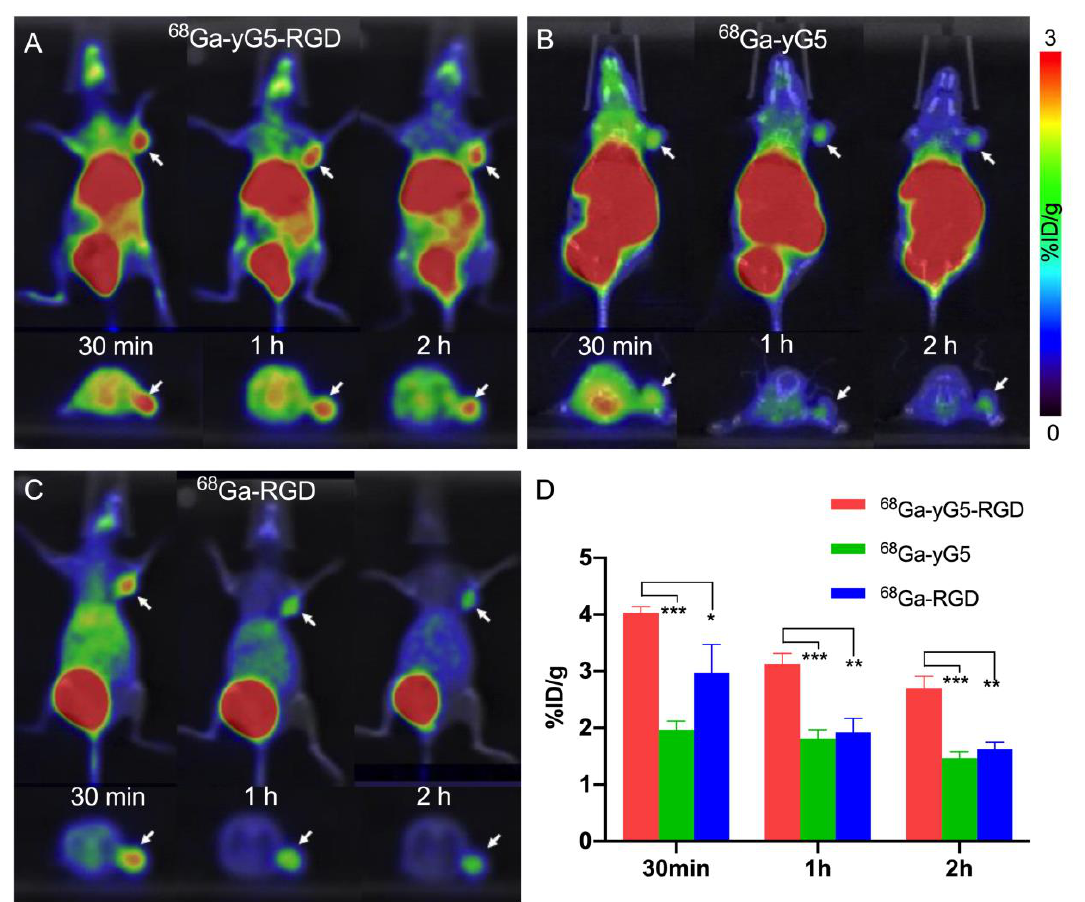
Figure 2. PET/CT scan of 68 Ga-yG5-RGD in BxPC3 tumor-bearing mice. ( A ) Representative static PET/CT images of BxPC3 xenograft tumor mice at 30 min, 1 h, and 2 h p.i. of 68 Ga-yG5-RGD, ( B ) 68 Ga-yG5, and ( C ) 68 Ga-RGD (each 5.55–7.4 MBq). ( D ) Tumor uptakes determined by quantitative ROI analysis of PET/CT images. Arrows indicate the location of tumors, n = 4; * p < 0.05, ** p < 0.01, *** p < 0.001.